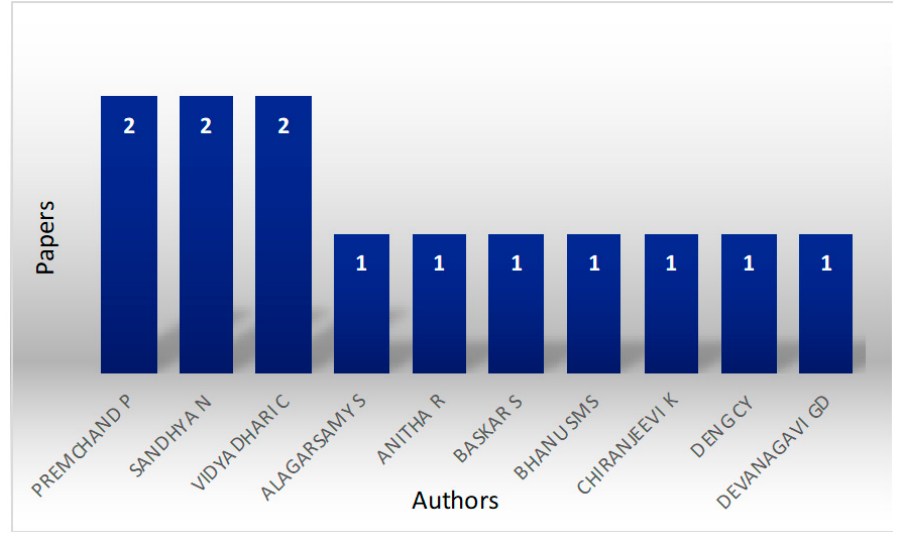
Figure 18. Record by authors for topic: Optimization fuzzy clustering with bat algorithm.